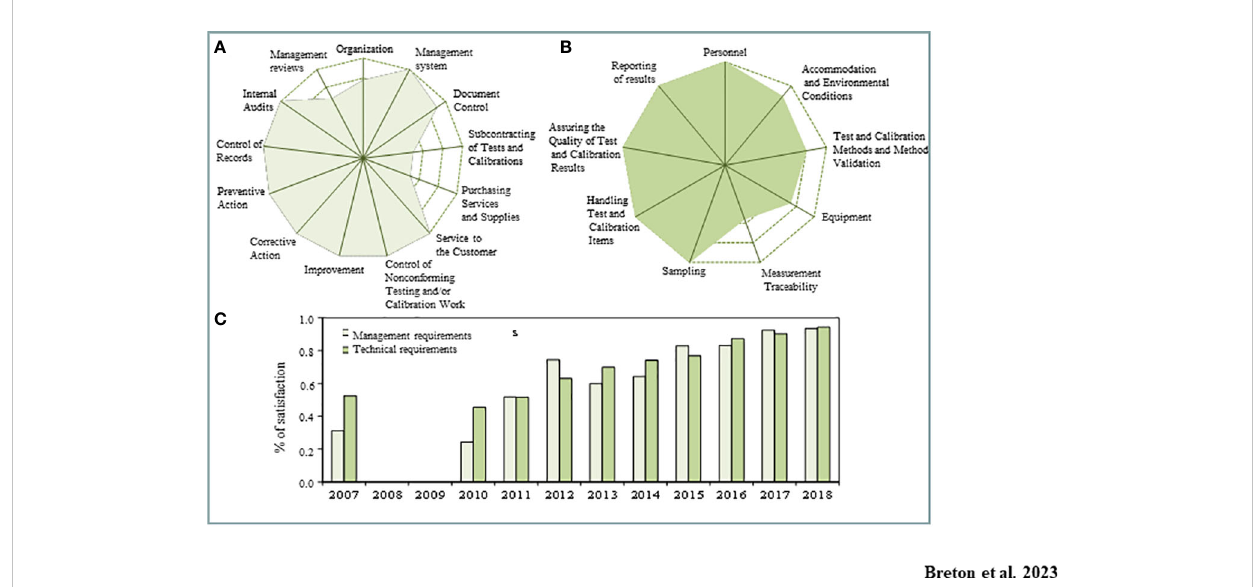
FIGURE 4 Internal/external audits of the SOMLIT network guided by the ISO 17025 standard (ISO-13528, 2005) to ensure the integrity of data and minimize errors: example of reports provided by one SOMLIT laboratory. (A, B) Management and technical requirements, respectively. (C) Temporal variations of the percentage (%) of satisfaction to meet the